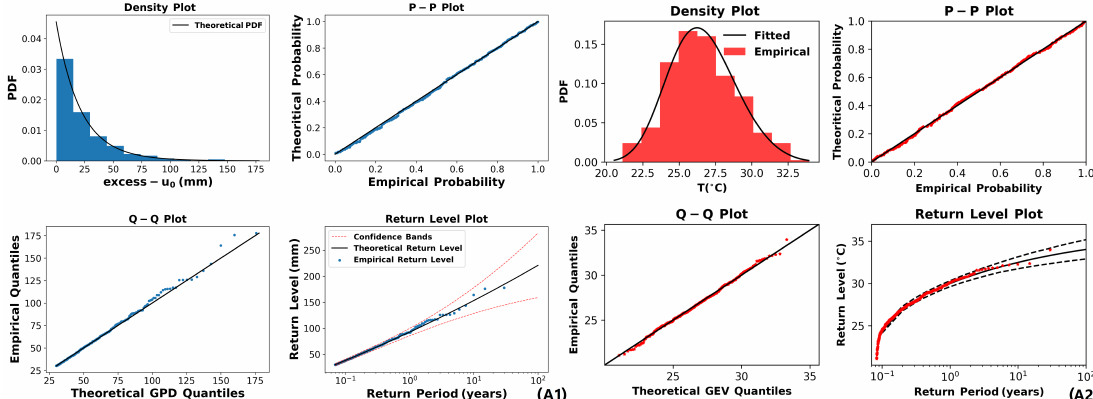
Figure A1. Diagnostic plot for Castrovillari station. ( A1 ) Rainfall diagnostic plot. ( A2 ) temperature diagnostic plot.